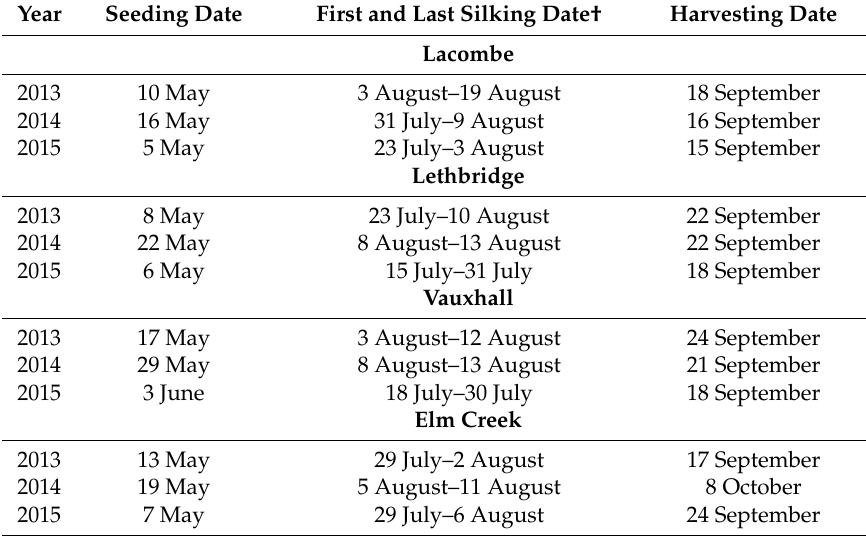
Table 3. Seeding date, the first and the last mean silking date, and harvesting date for corn hybrids grown at Lacombe, Lethbridge, and Vauxhall (Alberta) and Elm Creek (Manitoba) over three